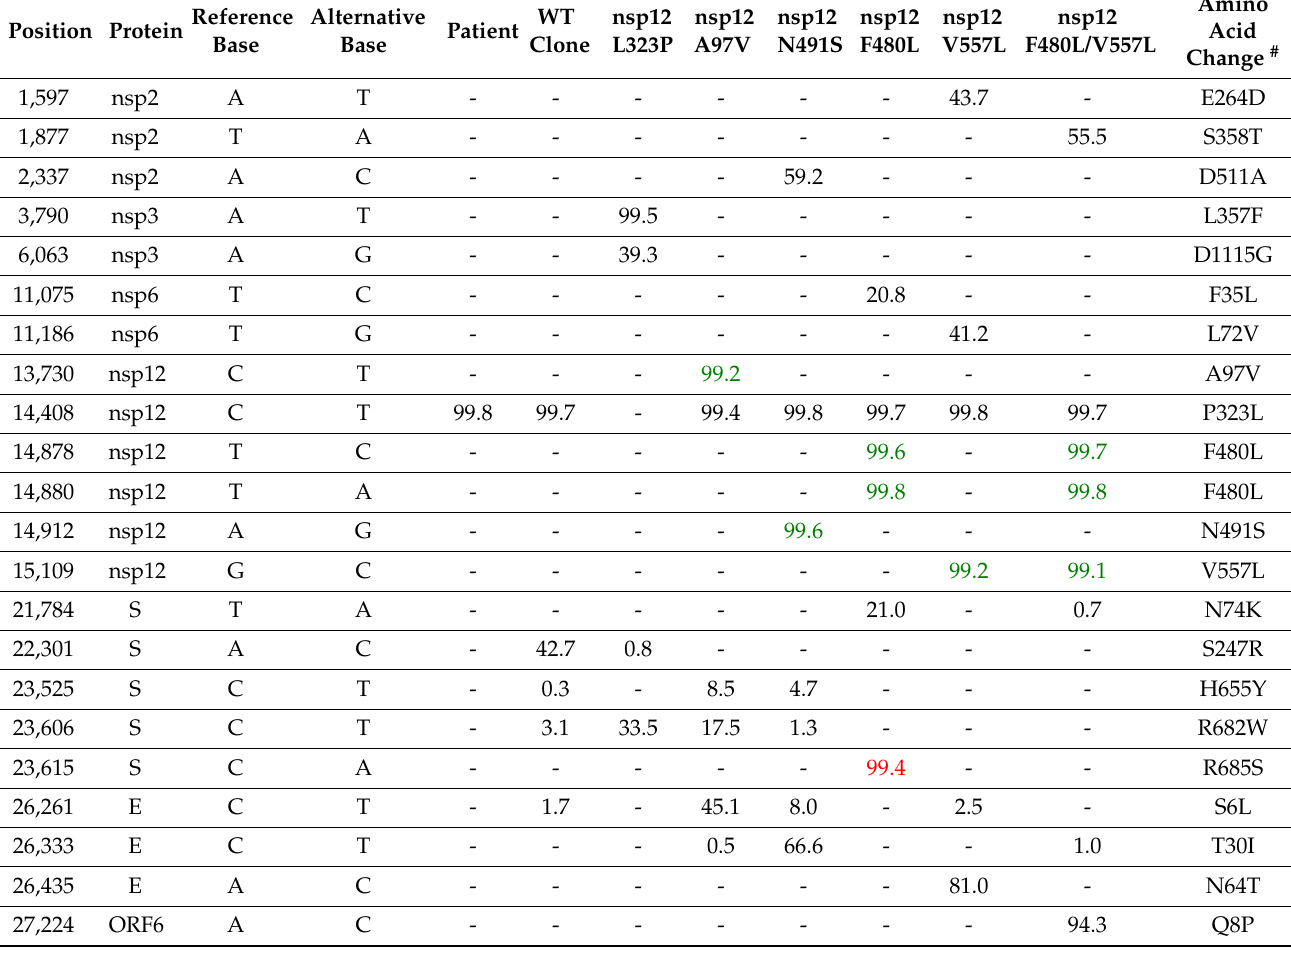
Table 2. Sequence of the SARS-CoV-2 viruses recovered in second passage in Vero E6 cells. The full-length coding regions of the viruses were obtained by NGS. Only non-synonymous SNPs with frequencies >20% are shown. The sequences were compared to Wuhan reference sequence (NC_045512) but only the polymorphism P323L is reported in the